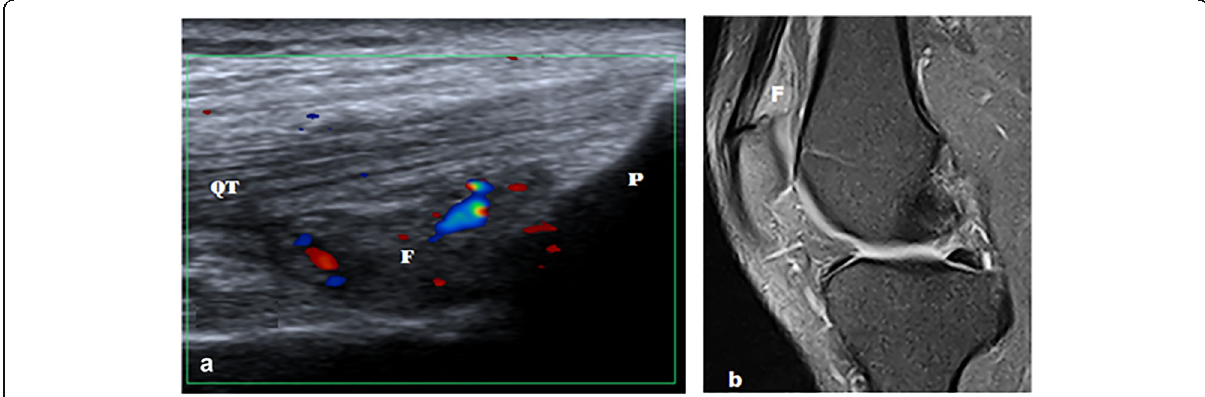
Fig. 10 A 37-year-old male with left suprapatellar pad of fat impingement. a Long axis ultrasound image shows hypoechoic suprapatellar fat pad with convex posterior margin. Color Doppler ultrasound shows increased vascularity. b Sagittal PDFS MR image shows hyperintense suprapatellar fat pad with convex posterior margin. QT, quadriceps tendon; P, patella; F, suprapatellar fat pad